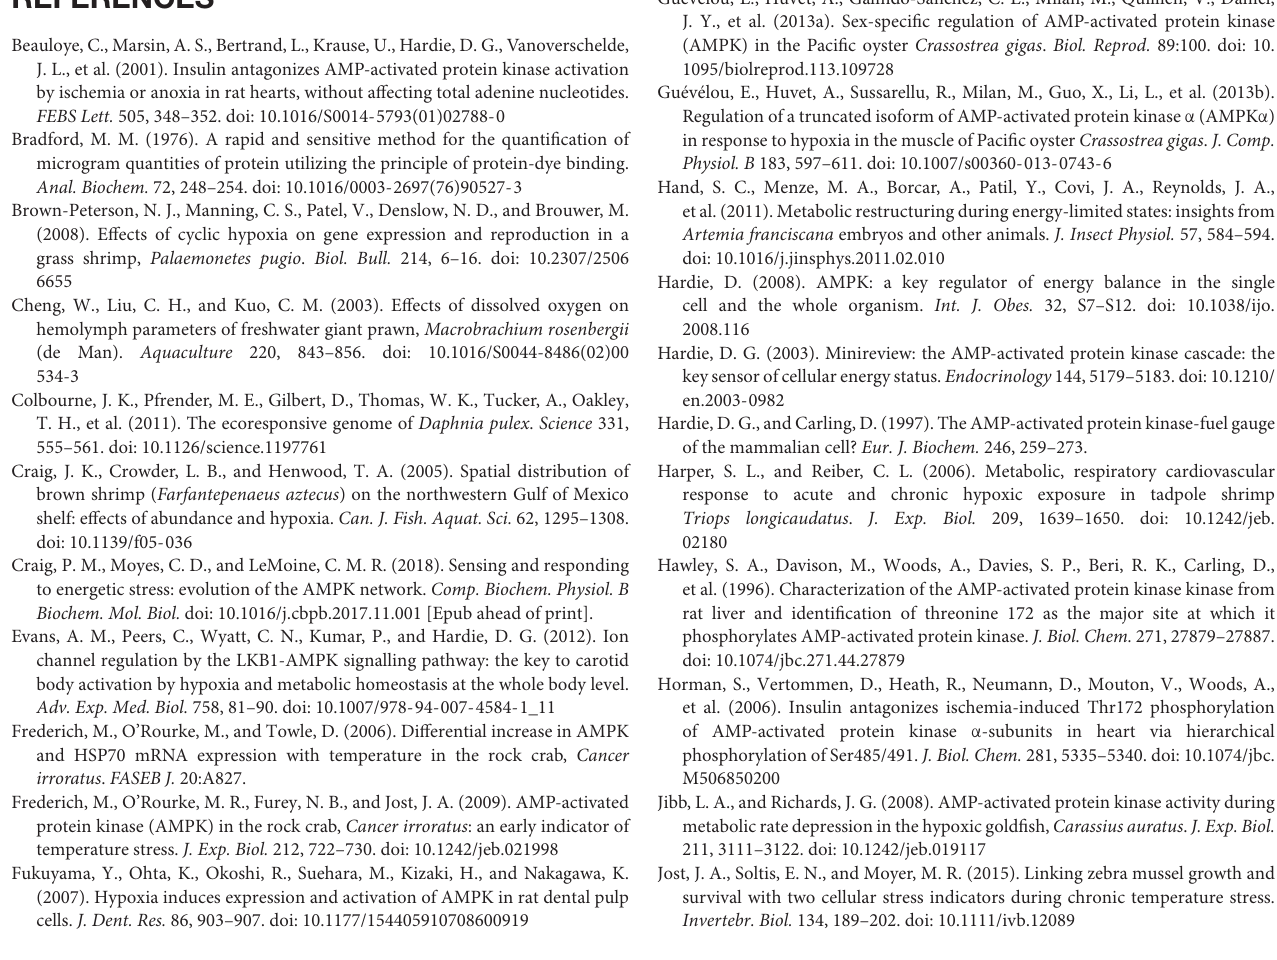
indicate the translated region, lowercase letters indicate the untranslated region, and the asterisk indicates the stop codon. Cystathionine beta-synthase (CBS pair) domains are underlined. FIGURE S4 | Amino acid alignment of AMPK α from M. nipponense with ten other known sequences of the AMPK α subunit: Litopenaeus vannamei (AKE50479.1), Homo sapiens (NP_006243.2), Rattus norvegicus (NP_076481.1), Bos taurus (NP_001192534.1), Charadrius vociferous (KGL92907.1), Danio rerio (NP_001103756.1), Drosophila melanogaster (NP_726730.1), Aedes aegypti (XP_001652572.1), Cancer irroratus (ACL13568.1), and Artemia franciscana (ABI13783.1). FIGURE S5 | Amino acid alignment of AMPK β from M. nipponense with eight other known sequences of the AMPK β subunit: Litopenaeus vannamei (AKE50480.1), Homo sapiens (NP_005390.1), Rattus norvegicus (NP_072149.1), Bos taurus (NP_001179257.1), Gallus gallus (NP_001038127.1), Branchiostoma FIGURE S6 | Amino acid alignment of AMPK γ from M. nipponense with twelve other known sequences of the AMPK γ subunit: Litopenaeus vannamei (AKE50481.1), Homo sapiens (NP_001035723.1), Rattus norvegicus (NP_908940.1), Bos taurus (NP_001025473.2), Cuculus canorus (KFO74243.1), Bombyx mori (NP_001119720.1), Salmo salar (ACI33670.1), Drosophila melanogaster (NP_732599.1), Aedes aegypti (XP_001659398.1), Cancer irroratus (ACL13567.1), Homarus americanus (AEO22037.1), and Carcinus maenas